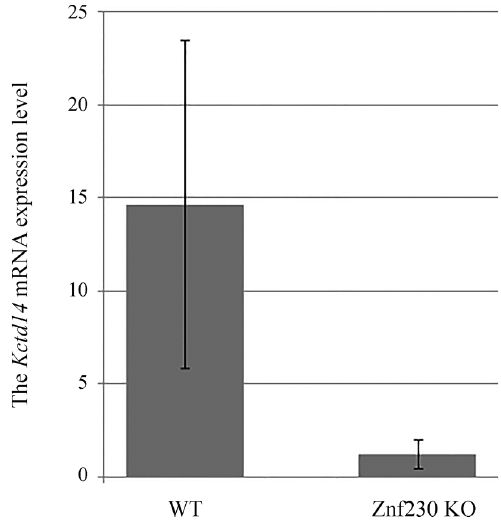
Figure 4 - Comparative qRT-PCR analysis of mRNA levels of the Kctd14 gene between Znf230 KO and C57BL/6J (WT) mice. Bars represent the means ± S.D., Statistical p-values <